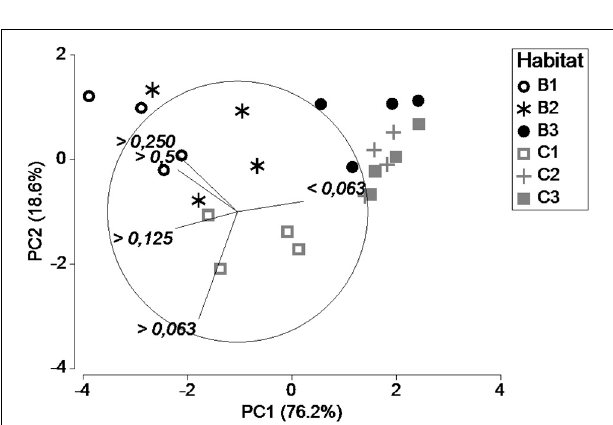
FIGURE 3 | Principal component analysis, explaining 94.8% of the variation in grain size in the six habitats during the four seasons. B1–3 signifies the Beach habitats and C1–3 the Creek habitats. Variation explained by PC1 is 76.2% while PC2 explained